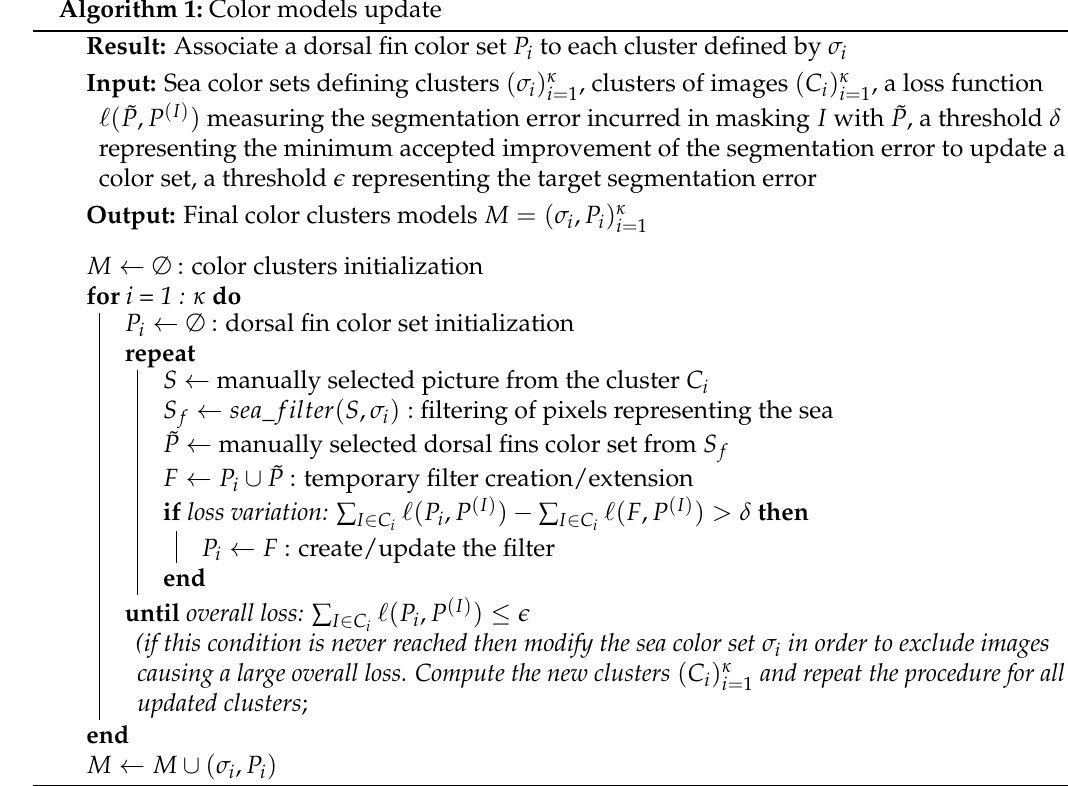
Algorithm 1: Color models